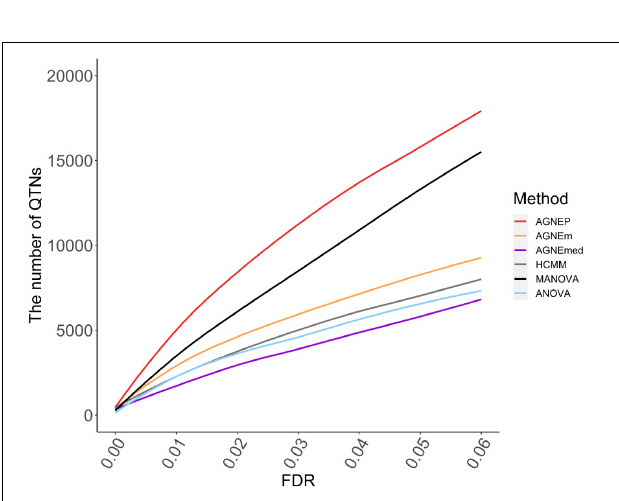
FIGURE 5 | Numbers of QTNs under various FDR detected by six methods for the Arabidopsis